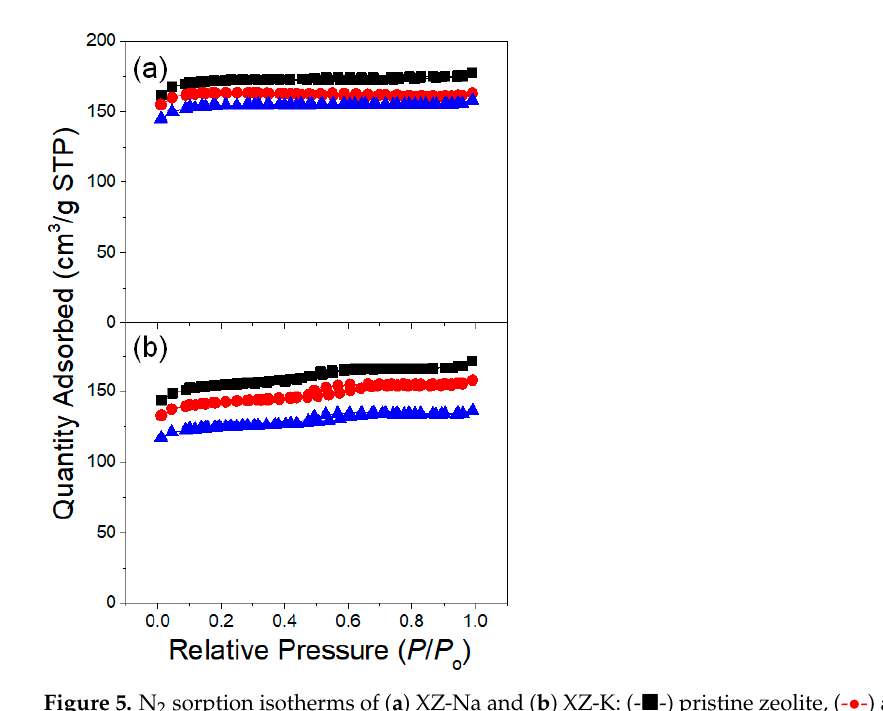
Figure 4. Recycling of XZ-Na and XZ-K for the etherification reaction of glycerol.